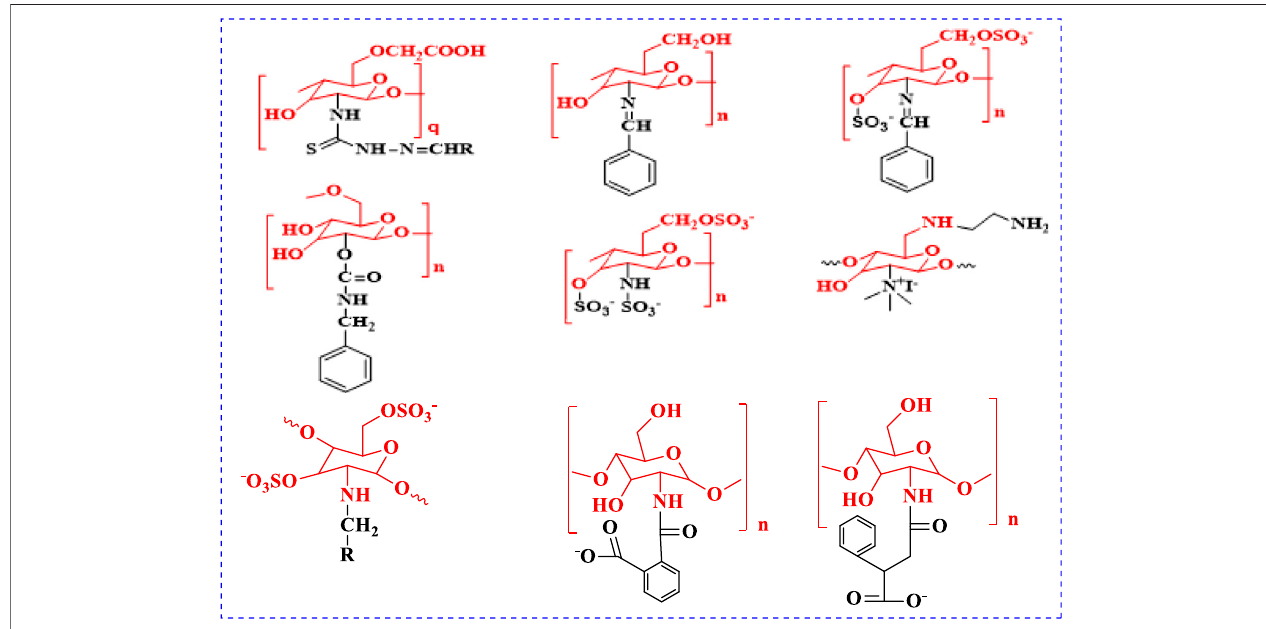
FIGURE 1 | Anticancer active compounds of chitosan